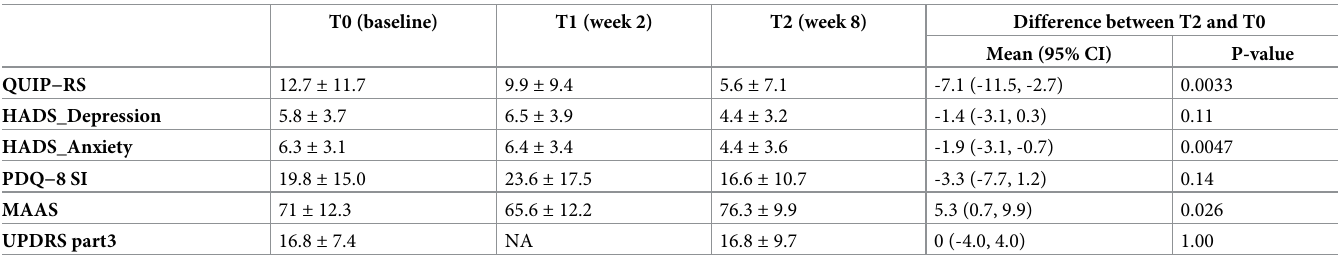
Table 2. Secondary outcomes of clinical